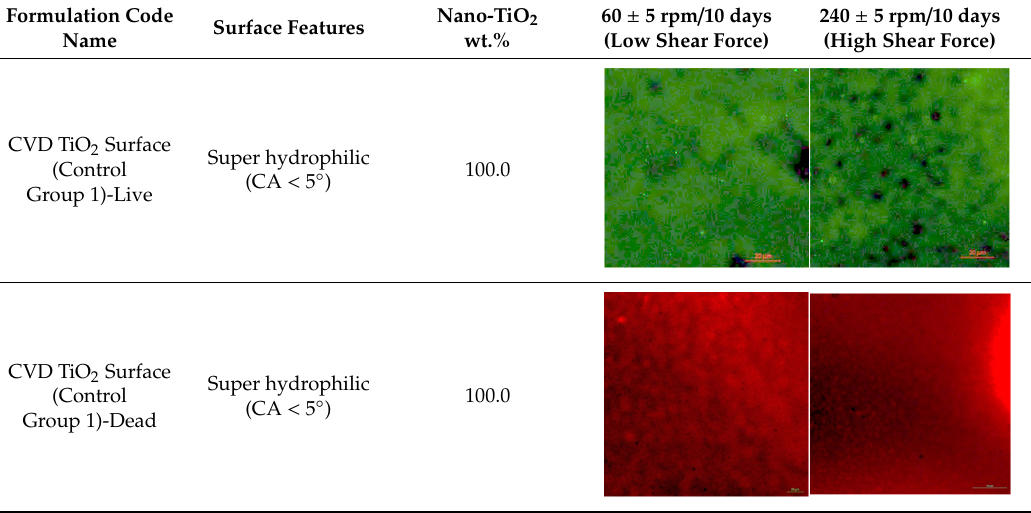
Table 3. Live/dead microscopy of control group with pure nano-scale TiO 2.